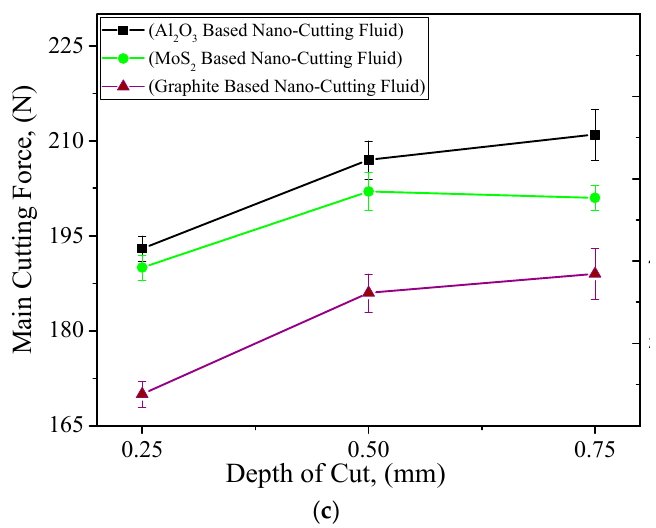
Figure 4. Effect of cutting parameters on main cutting forces. ( a ) Cutting Speed, where f = 0.15 mm/rev & a p = 0.50 mm; ( b ) Feed Rate, where Vc = 250 mm/rev and a p = 0.50 mm; ( c ) Depth of Cut, where Vc = 250 mm/rev and f = 0.15 mm/rev.